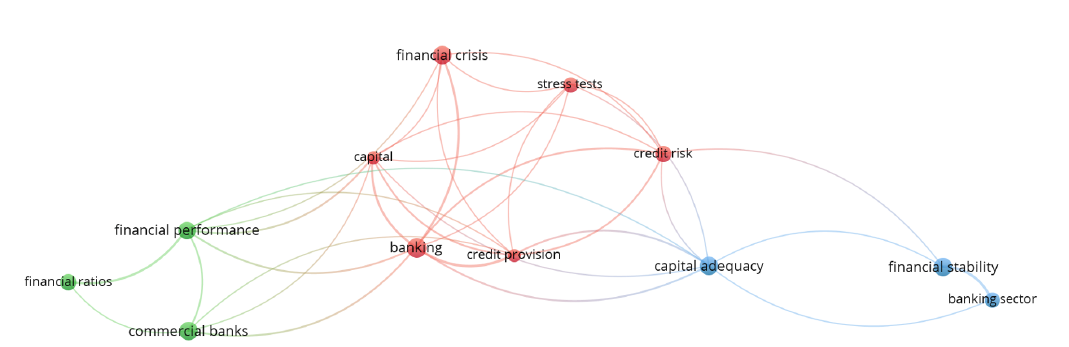
Figure 1: VOSviewer: Capital Adequacy